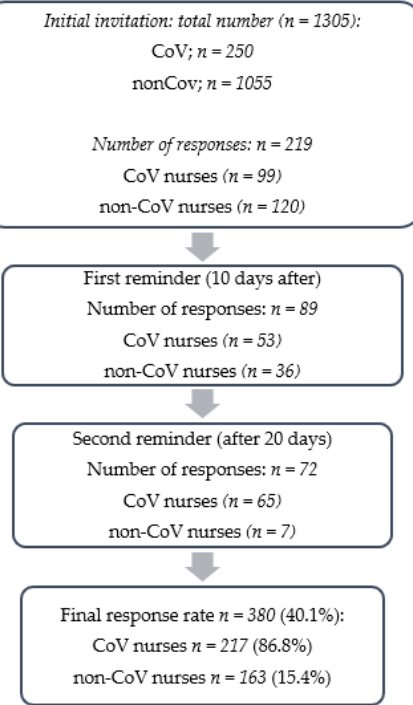
Figure 1. Flow chart of the study. 124